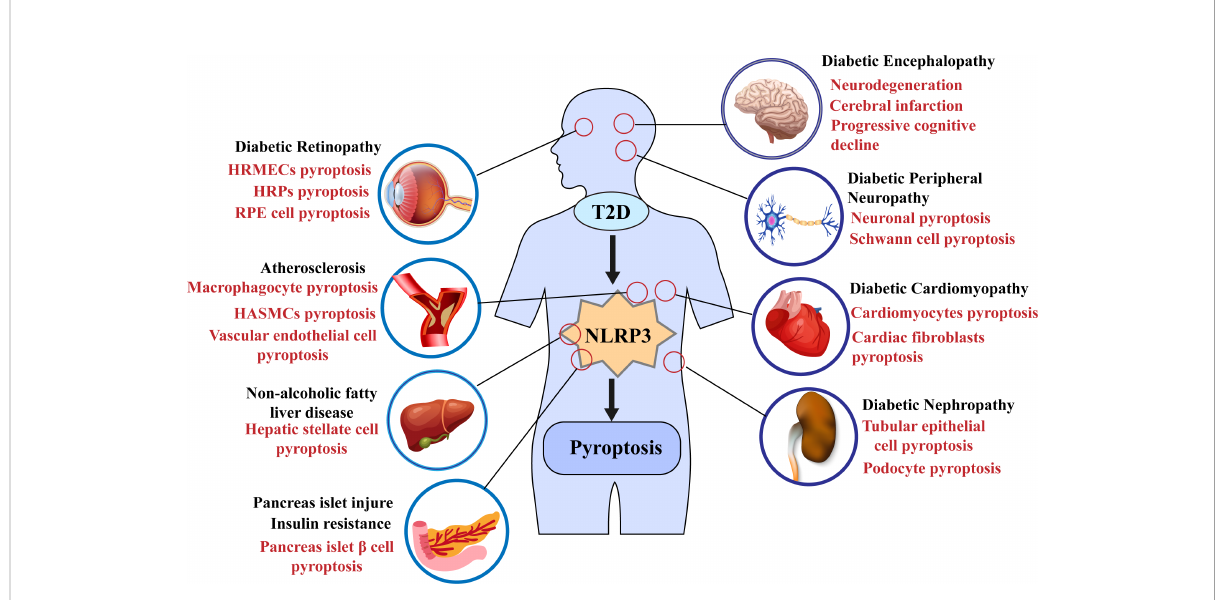
FIGURE 3 Pyroptosis mediated by the NLRP3 in fl ammasome in type 2 diabetes and its